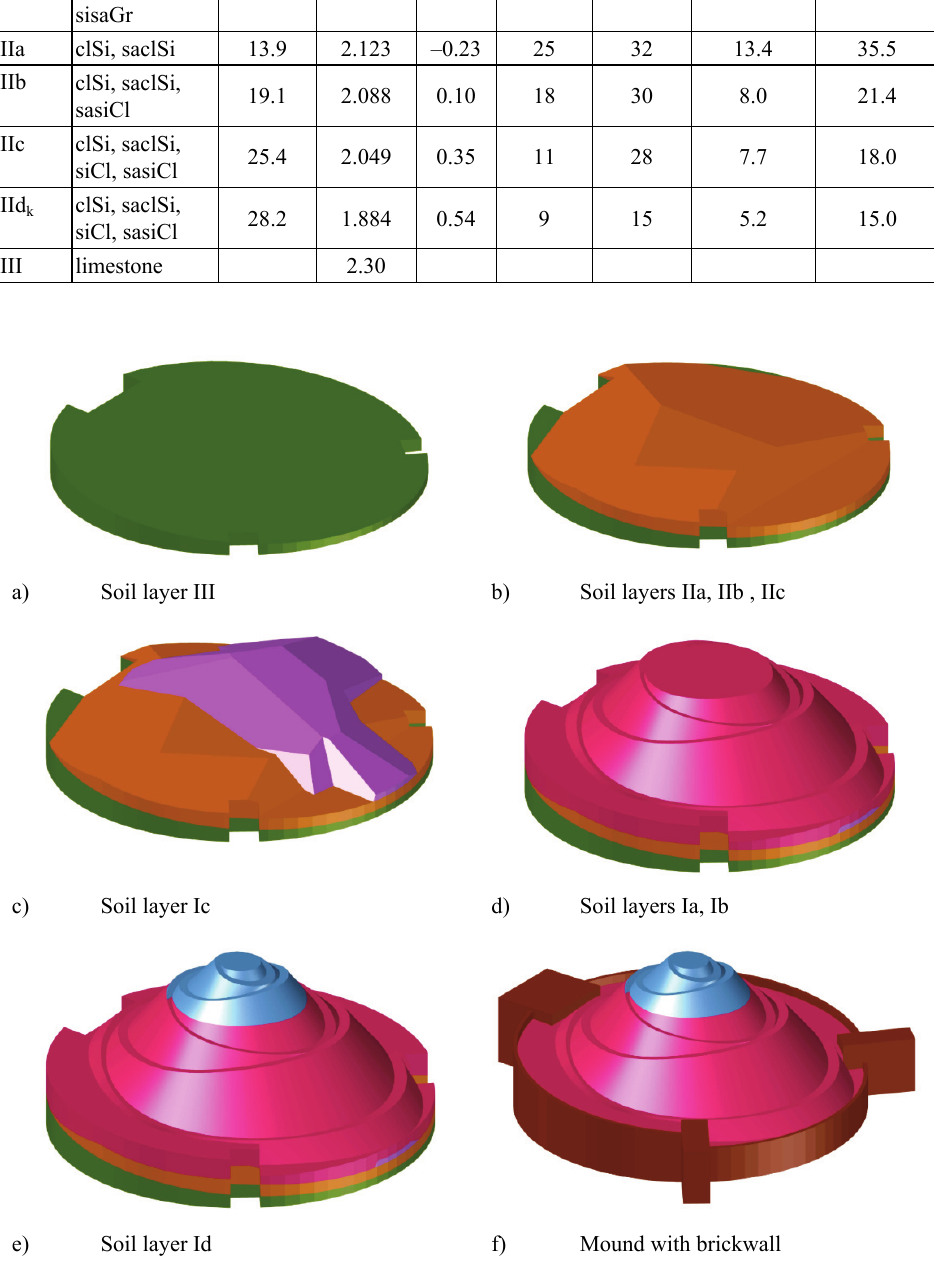
Fig. 2. Calculation of simplified soil